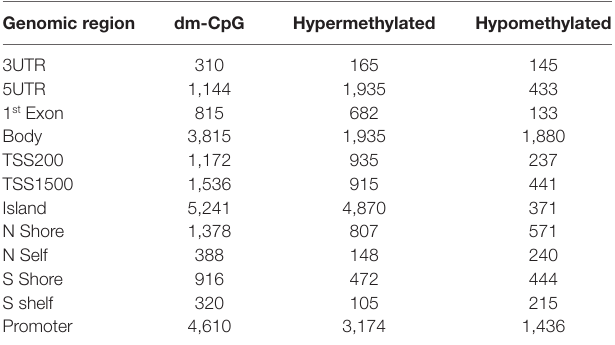
TABLE 2 | Differential methylation frequency per mega base-pair (Mb) for each autosomal